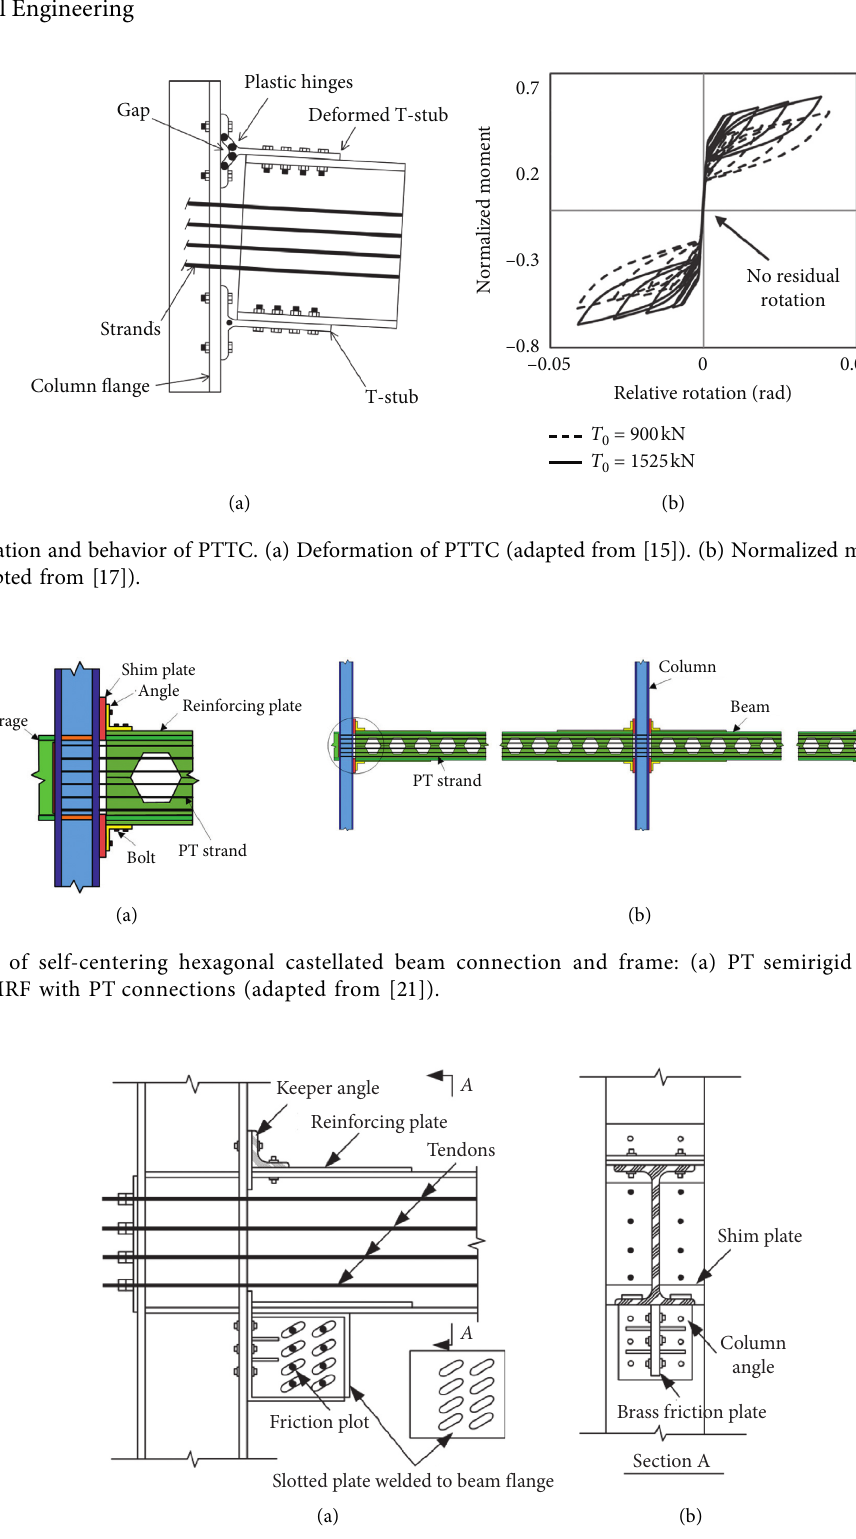
Figure 6: Self-centering beam-column connection with BFFD (adapted from [23]).